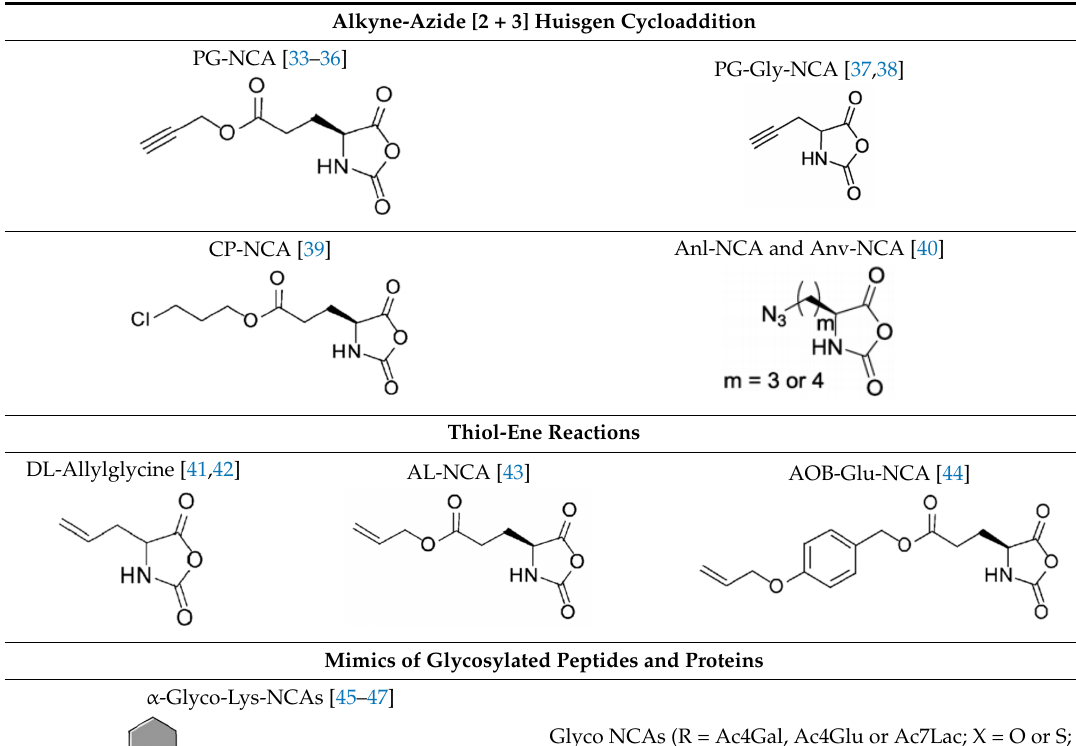
Table 1. Illustrative examples of functional NCAs. Adapted from reference [13].